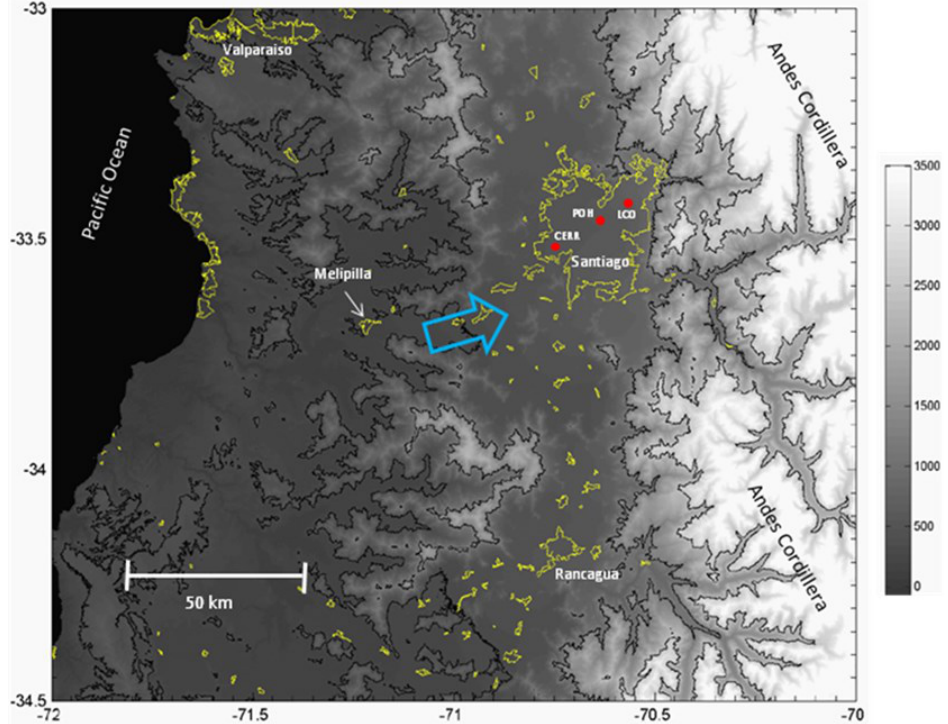
Figure 1. Topographic map of central Chile. Gray shading in m ASL; also indicated the 300, 1200 and 2400 m above sea level (ASL) topographic contours (black lines). Yellow lines outline main cities, red dots indicate the location of the MACAM (Air Quality Monitoring Program in Santiago Metropolitan Area) stations Cerrillos, Parque O’Higgins and Las Condes. The blue thick arrow indicates the predominant low-level winds from the SW during summer afternoon (adapted from [21], see also Figure 3).